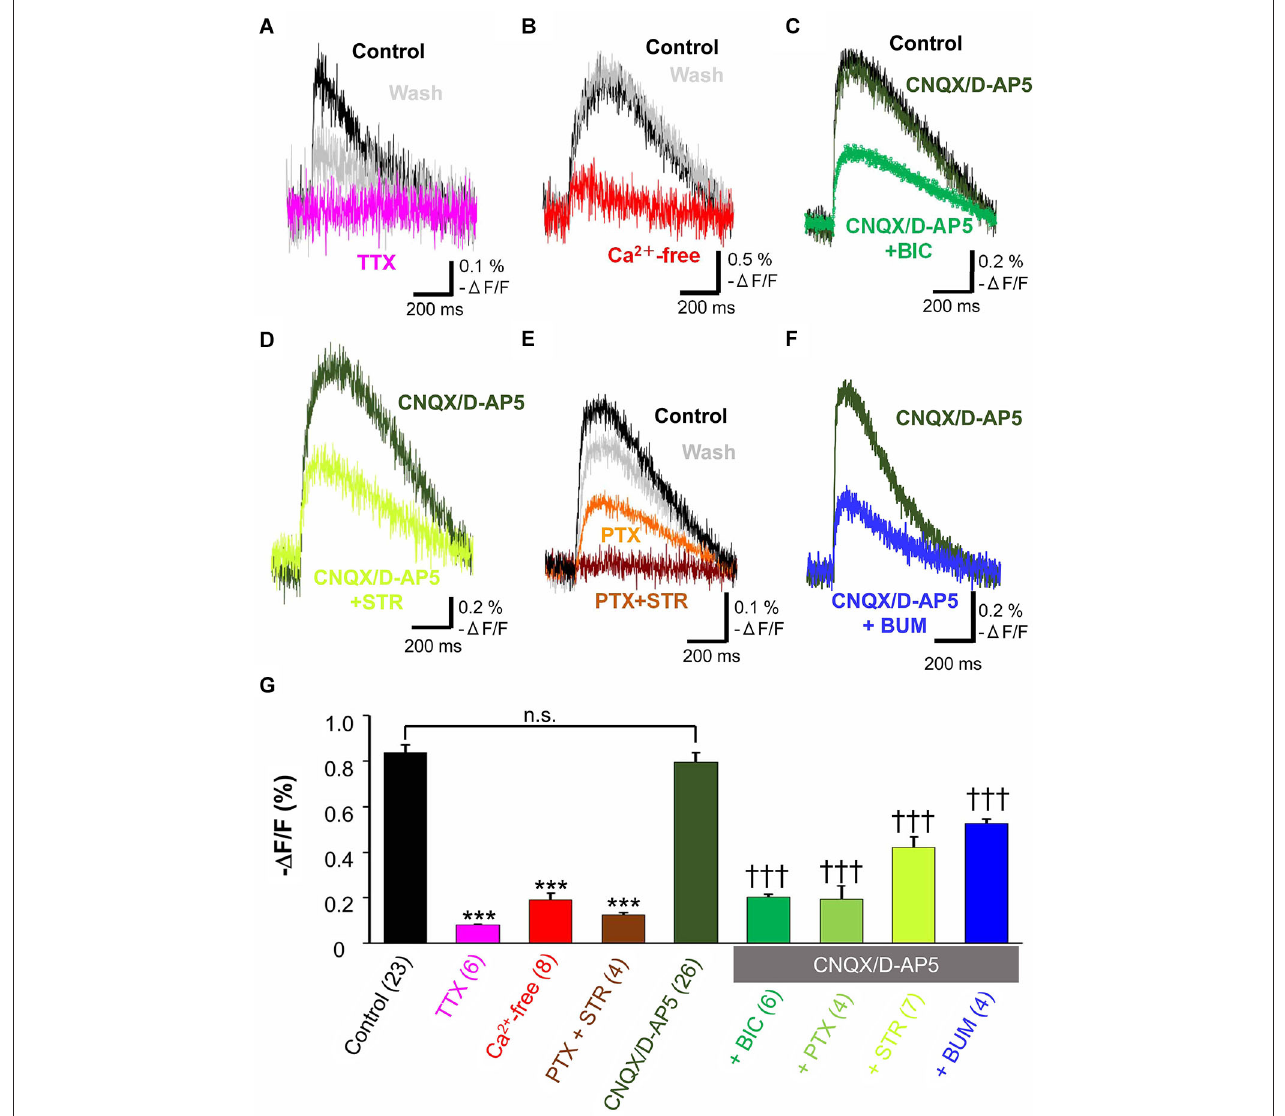
optical signal recovered after washing for 30 min (gray trace). (F) Evoked optical signals insensitive to glutamate receptor antagonists, CNQX